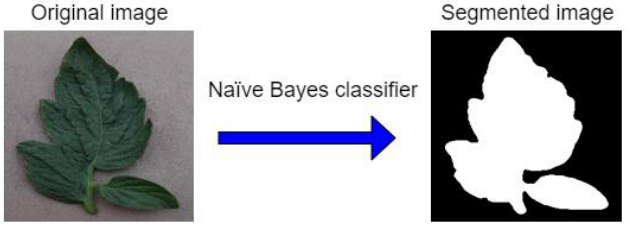
Figure 3. Example of the silhouette images (segmented image) used for training.